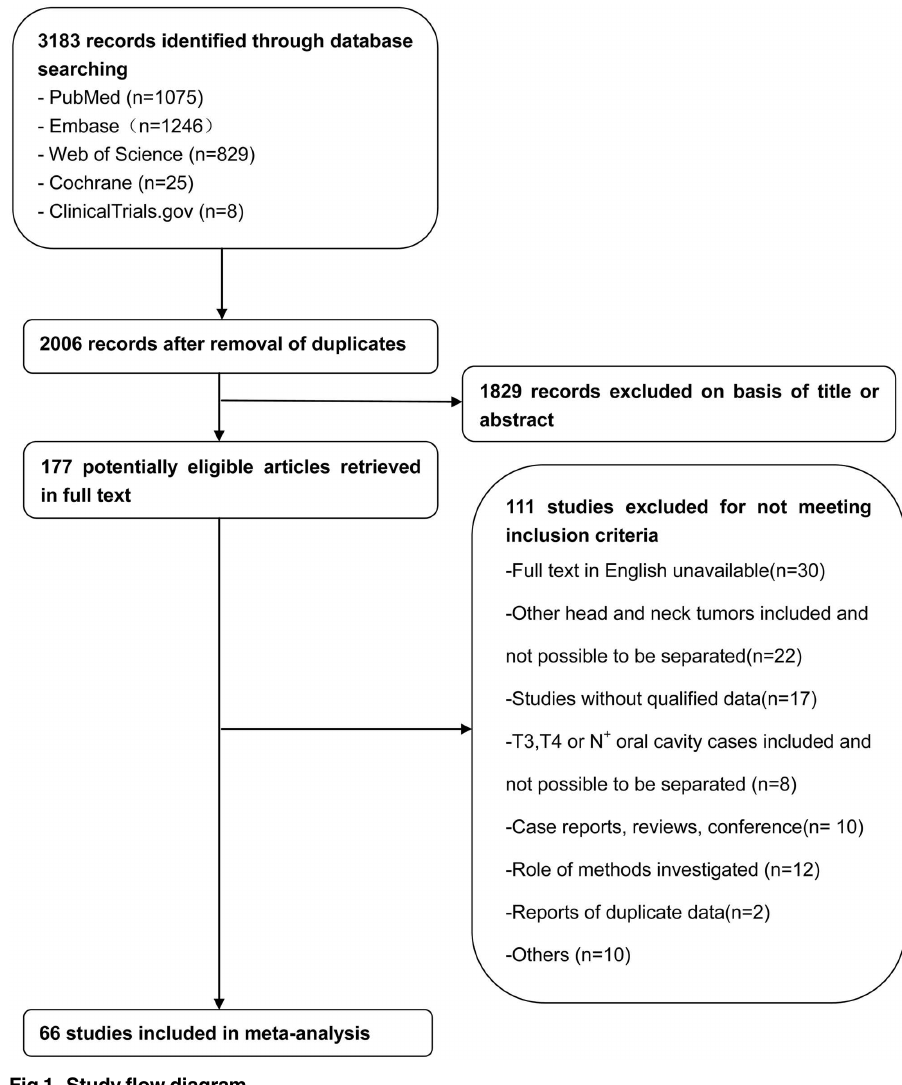
Fig 1. Study flow